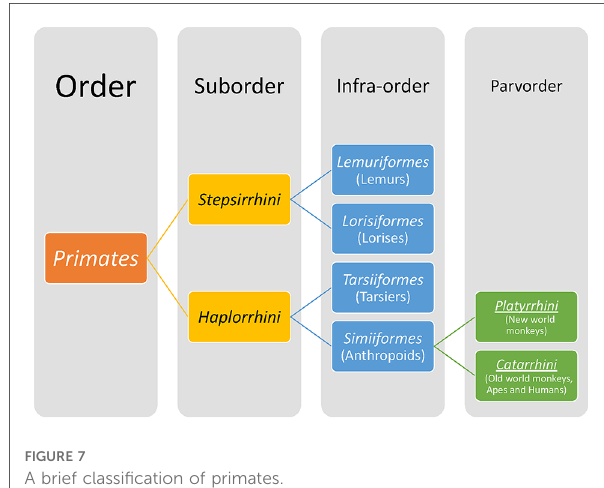
FIGURE 7 A brief classi fi cation of